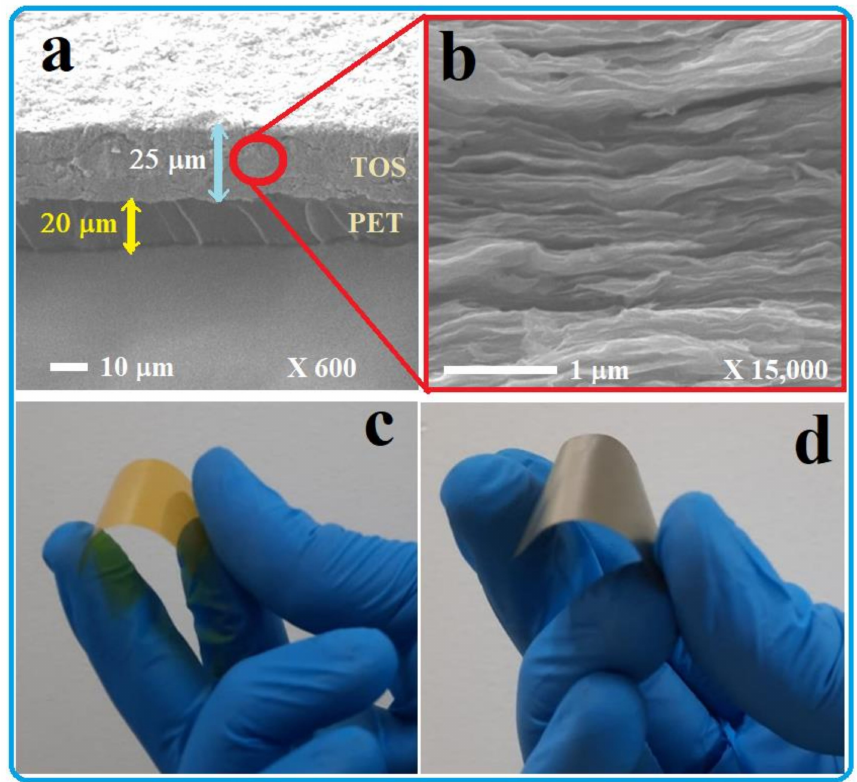
Figure 3. ( a ) SEM image of the TiS 2 /organic superlattice deposited on a PET substrate. ( b ) High- magnification SEM image of the TOS deposited on the PET substrate. Photographs of the PET film ( c ) without TOS and ( d ) with deposited